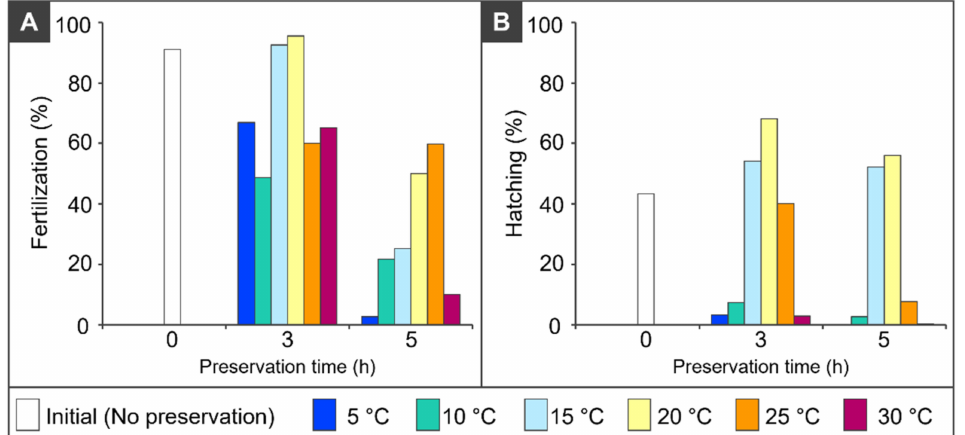
Figure 4. Developmental capacity after preservation of ovulated eggs of kawakawa Euthynnus affinis in different temperatures. ( A ) Fertilization rate and ( B ) hatching rate after the preservation of ovulated eggs without artificial medium for 0, 3, and 5 h at 5 ◦ C, 10 ◦ C, 15 ◦ C, 20 ◦ C, 25 ◦ C, and 30 ◦ C. Statistical analysis could not be carried out because each value is the mean of the duplicate using ovulated eggs from two